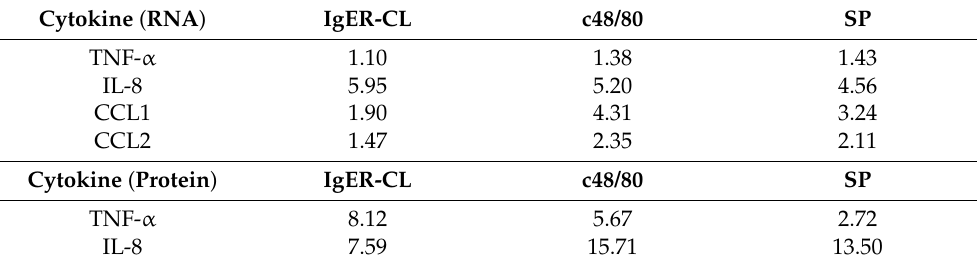
Table 1. Synergism factors for IL-33-induced cytokines (mRNA and protein). Cytokine ( RNA ) IgER-CL c48/80 SP TNF- α